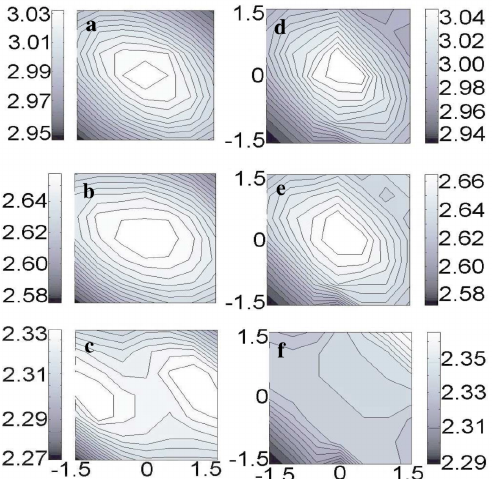
Figure 23. Simulated topographical FM-AFM images at three different frequency shifts ( ∆ f ), calcu- lated using f 0 = 16860Hz, k = 1800N/m, and A = 8Å [17]. Height variations (Å) are indicated by the bar next to image. The left panel is for a Si(001) tip: ( a ) at ∆ f = − 140Hz, a single maximum; ( b ) at ∆ f = − 150Hz, still a single maximum but with extended maximum area; ( c ) at ∆ f = − 160Hz, two maxima separated by 2Å. The right panel is for Si(111) tip: at all frequency shifts, only one maximum with its position shifted from the center ( d ), ( e ) to the upper-right corner ( f ). Adapted with permission by American Physical Society from Figure 4 in